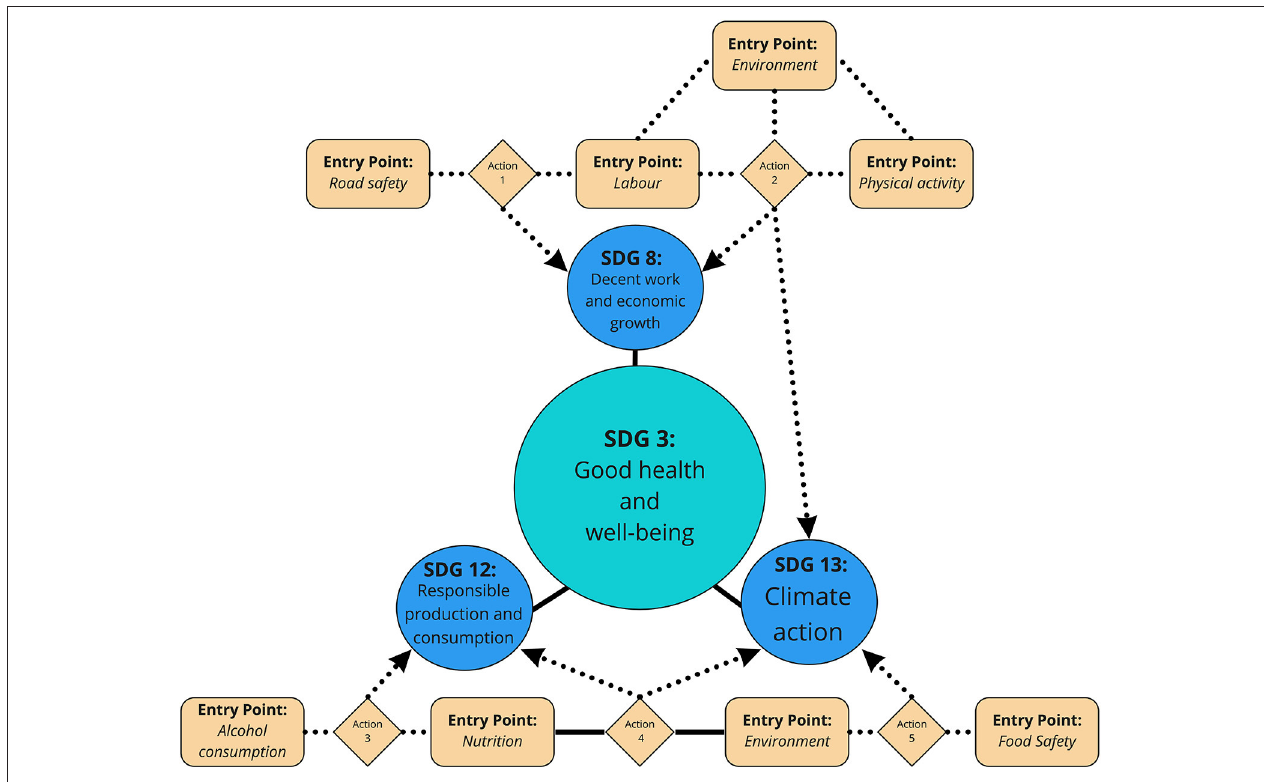
FIGURE 1 | Conceptual diagram identifying areas for entry points and Sustainable Development Goals relating to online food delivery services to merge, forming action points to ultimately address SDG 3 Good Health and Wellbeing. Actions are defined and described in detail in Table 1